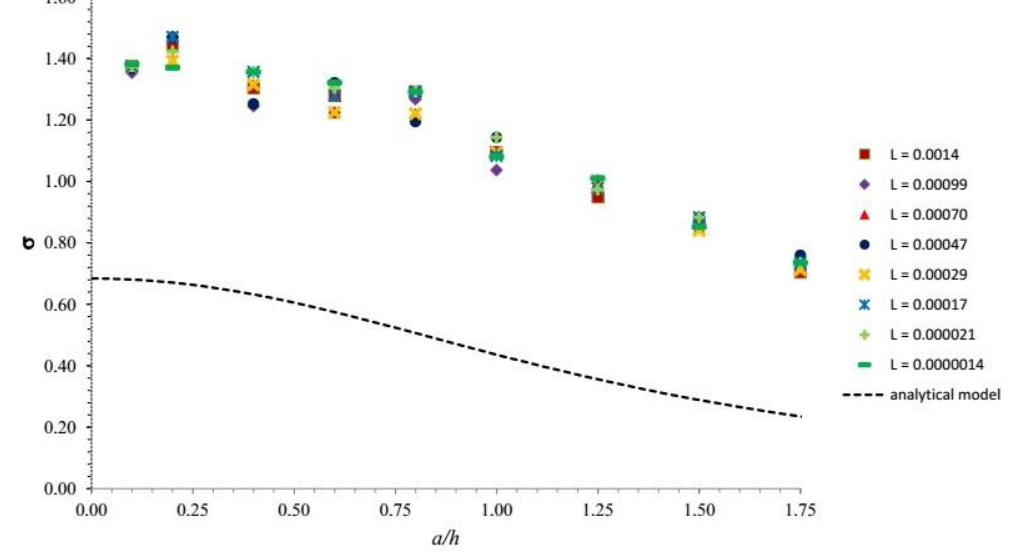
Figure 11. A comparison between Boussinesq’s analytical model for the half-space (dotted line) and the numerical COMSOL simulations for the finite case (markers) is reported for r T / h = 0.6, corresponding to the geometry of the e-skin prototype employed in the experimental section. As in Figures 8 and 10, σ vs. a/h is plotted. The role of the parameter L is included and confirms that distinct curves are associated with different values of L.